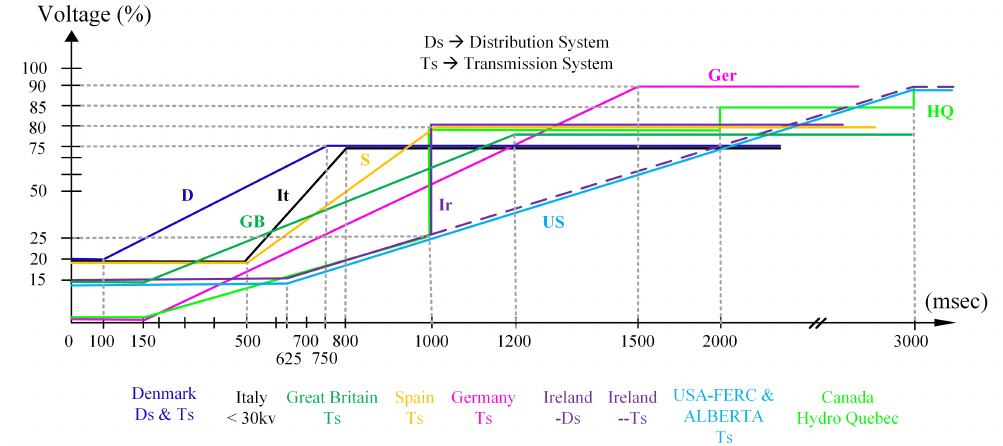
Figure 10. Grid-codes utilised by several countries. If the system is operating above the respective grid-code line, the M 3 C -based WECS must remain connected. Adapted from